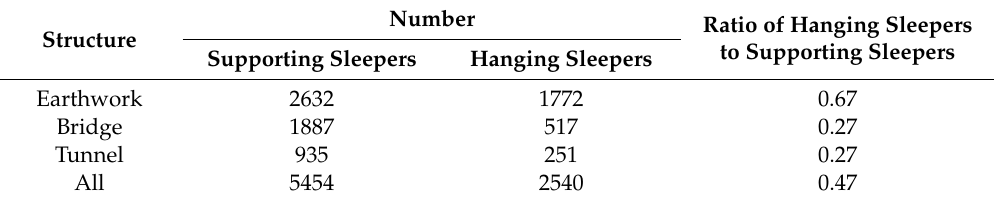
Table 4. Number of supporting sleepers versus hanging